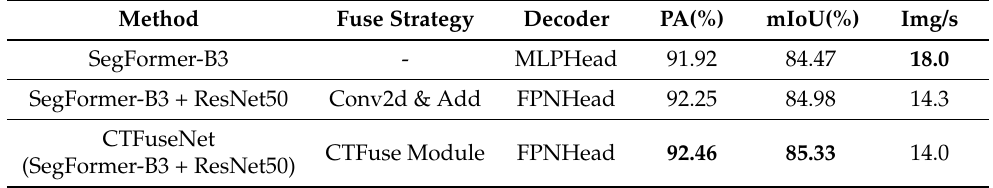
Table 3. Performance analysis of the feature fusion strategies. The best results are in bold.